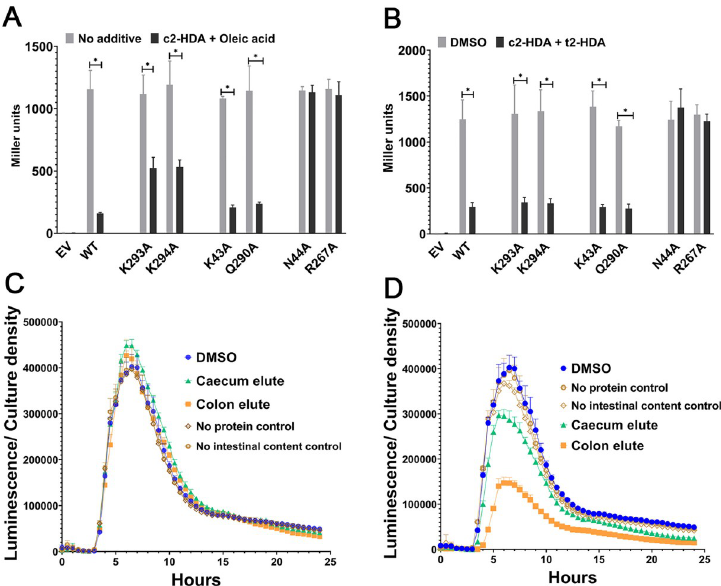
Fig 3. c2-HDA outcompetes other repressive LCFAs. (A-B) Salmonella strains expressing empty vector (EV) or wildtype (WT) or mutant HilD were grown in the presence of 20 μ M of each of c2-HDA, and oleic acid (A) or t2-HDA (B) and expression of sipB :: lacZY was measured by β -galactosidase assays. Bars represent mean ± SD (n = 4). Differences between respective untreated/ DMSO controls and fatty acid treatments were calculated by Mann- Whitney test, � p < 0.05. (C-D) Salmonella strain carrying hilA-luxCDABE transcriptional reporter fusion was grown in the presence of caecal or colon elutes from HilD K293A (C) or HilD Q290A (D) affinity columns. Luminescence was normalized to bacterial culture density. Data show mean ± SD of five